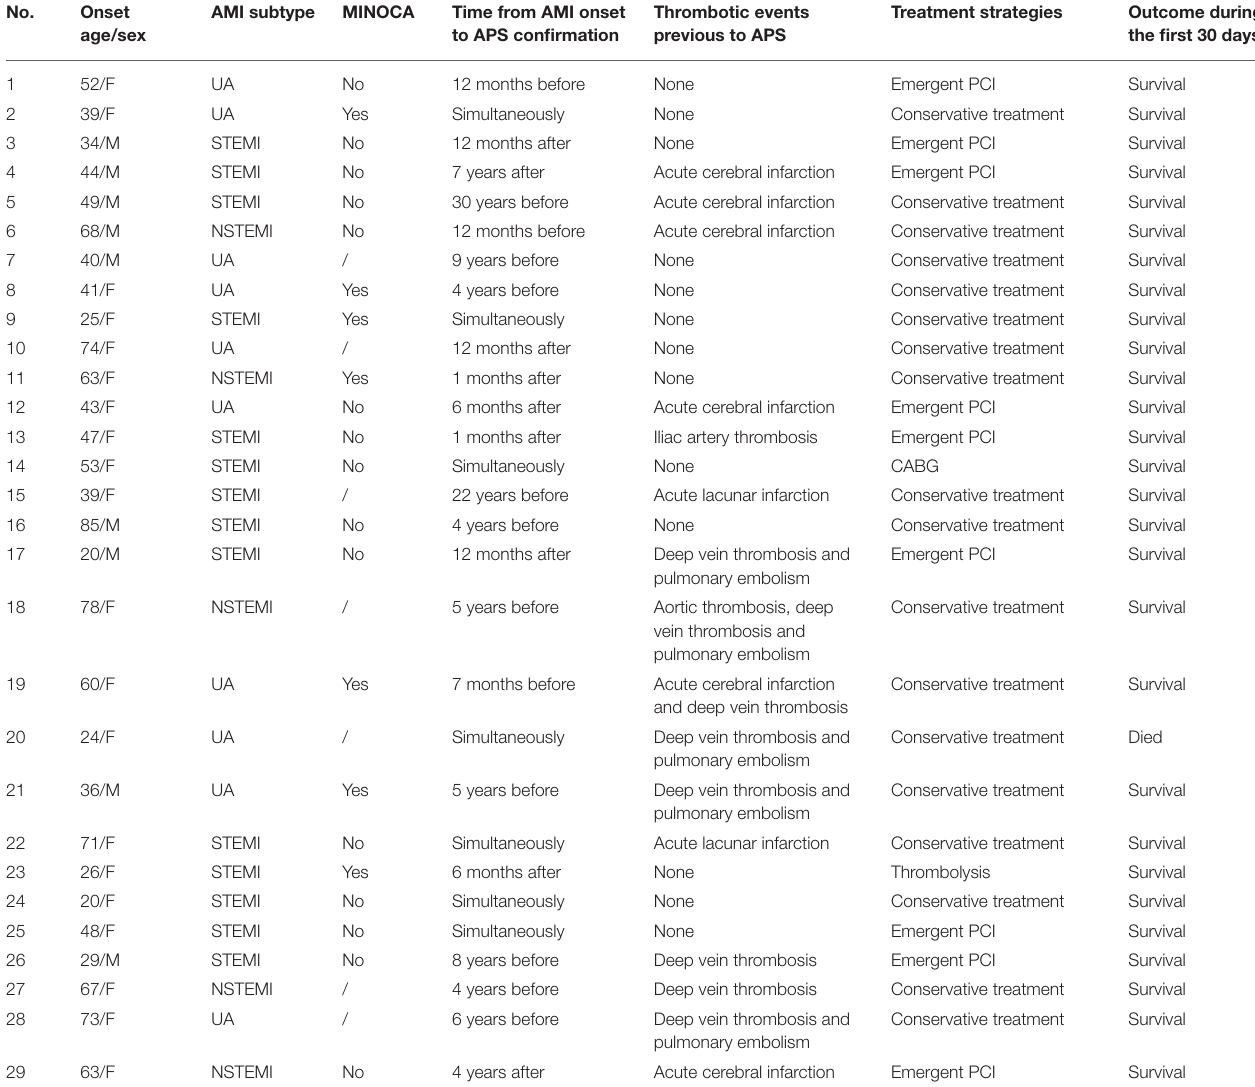
TABLE 1 | Detailed clinical profiles of APS patients with AMI.